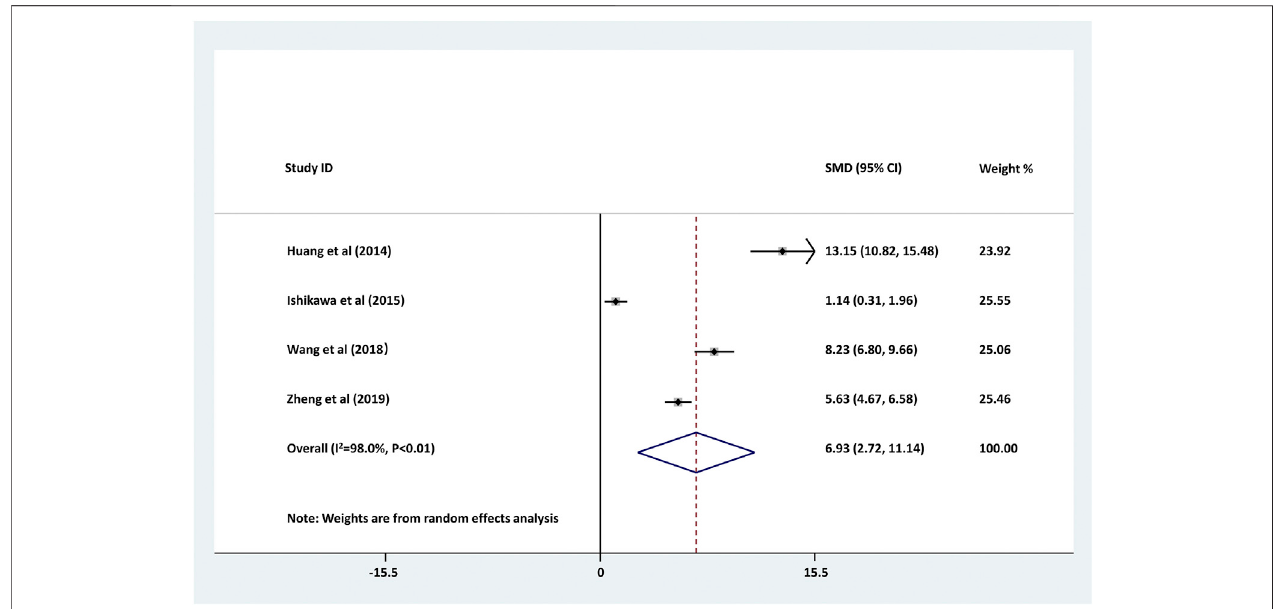
FIGURE2| ForestplotofstudiescomparingserumCRPlevelsbetweenchildhoodepilepsyandthehealthycontrols.IncreasedserumCRPwasfoundinchildhood epilepsy (pooled SMD: 6.930, 95% CI: 2.716 – 11.143, z = 3.22, p < 0.01). The between-study heterogeneity was large ( τ 2 = 17.911, Chi 2 = 148.67, df = 3, p < 0.01, I 2 =